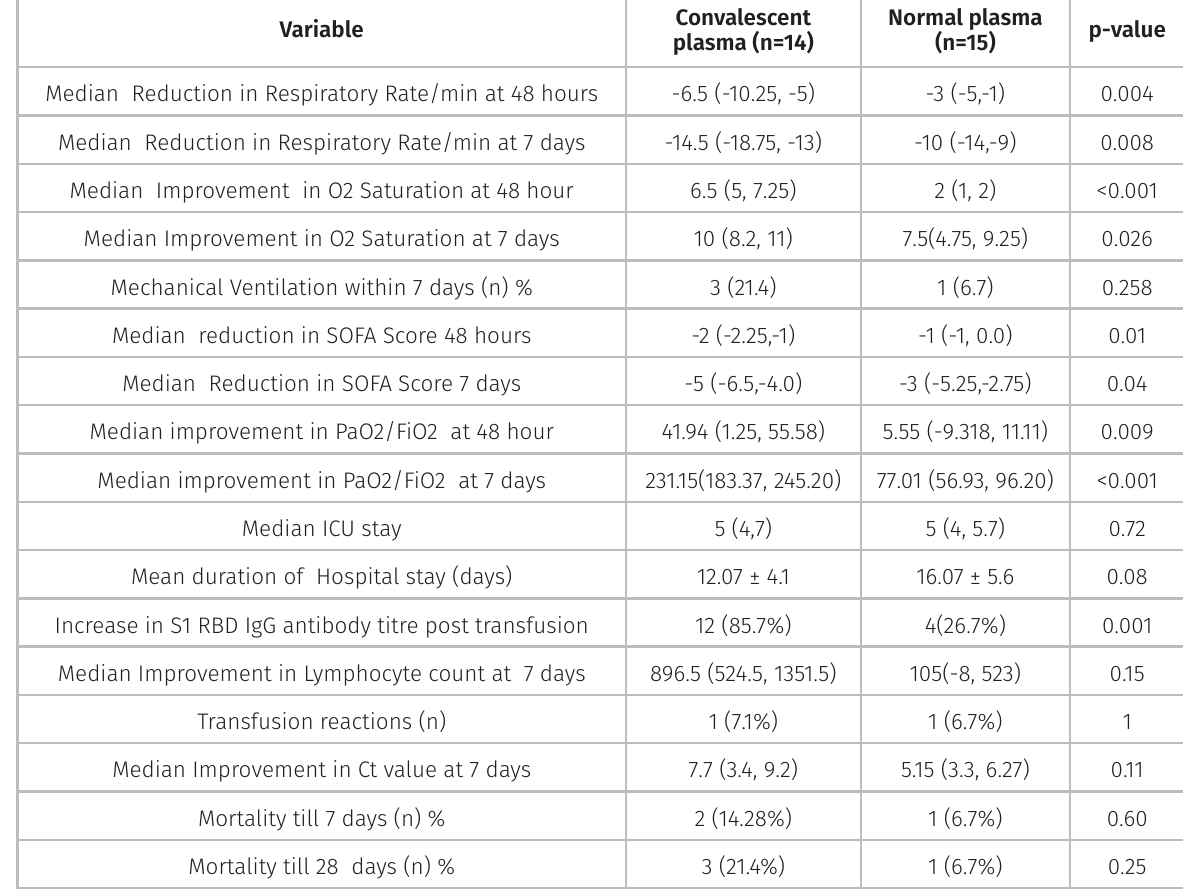
Table II. Changes in clinical outcome